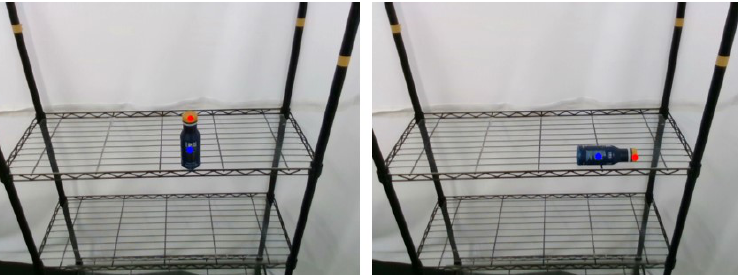
Figure 10. Keypoint detection results of PET bottle obtained by the proposed object pose estima- tion